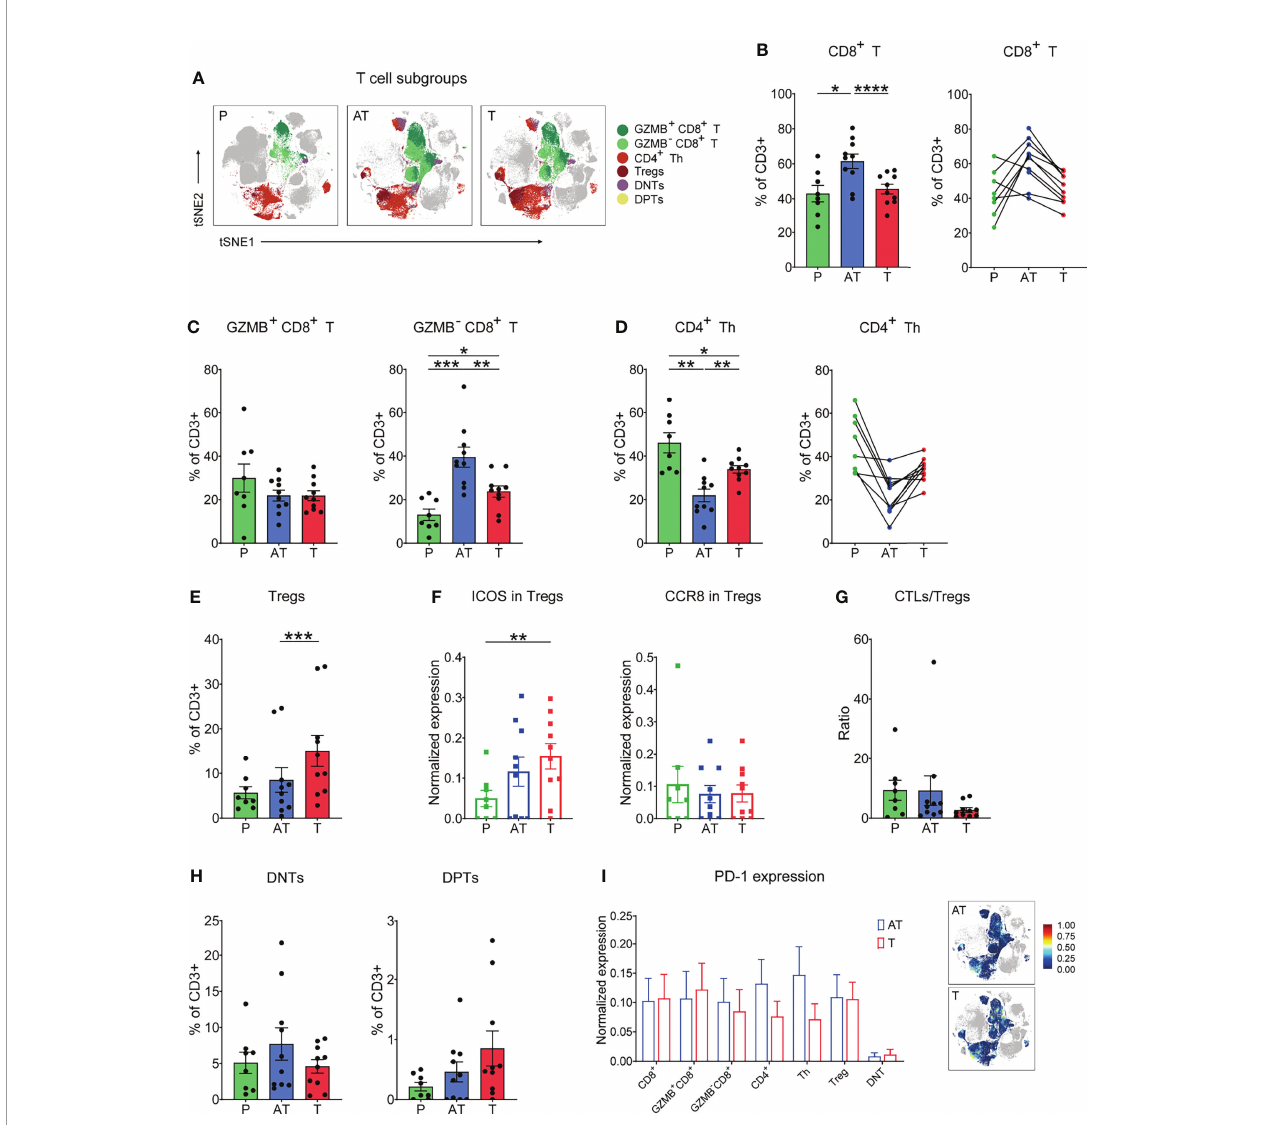
FIGURE 2 | In-depth characterization of the amount and function of T-cell (CD3 + ) compartments in the three types of samples (% of CD3 + T cells). (A) tSNE plots showing the distribution of the T-cell subgroups in different types of GC samples. (B) Frequency (left) and individual characterization (right) of CD8 + T cells for each patient based on summation of Phenograph clusters. (C) Frequency of GZMB + CD8 + (left) and GZMB - CD8 + (right) T-cell clusters for each patient based on summation of Phenograph clusters. (D) Frequency (left) and individual characterization (right) of CD4 + helper T (Th) cells for each patient based on summation of Phenograph clusters. (E) Frequency of Tregs for each patient based on summation of Phenograph clusters. (F) Expression level of ICOS and CCR8 in Tregs for each patient based on summation of Phenograph clusters. (G) Cytotoxic T lymphocyte (CTLs)/Treg ratio for each patient based on summation of Phenograph clusters. (H) Frequency of CD4 - CD8 - double-negative T (DNT) and CD4 + CD8 + double-positive T (DPT) cells for each patient based on summation of Phenograph clusters. (I) Expression level of PD-1 in different T-cell subgroups (left) and tSNE maps of relative expression of the PD-1 for T cell subgroups in GC samples of adjacent tissues and tumor tissues. Bar plots show mean ± SEM; *p < 0.05, **p < 0.01, ***p < 0.001, and ****p < 0.0001 by paired